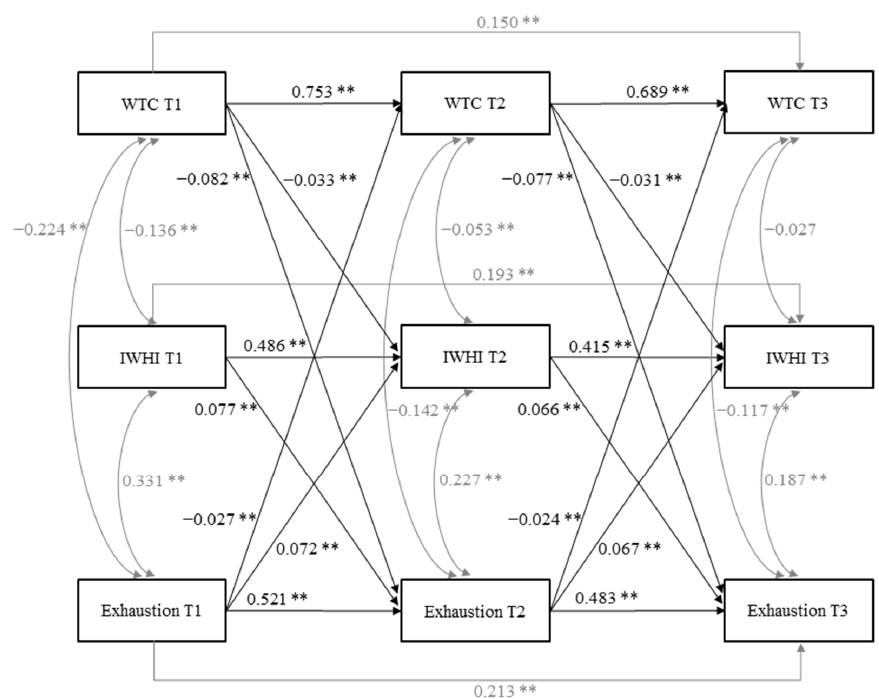
Figure A1. Final model (M5) with standardized coefficients for WTC, IWHI, and exhaustion (unbalanced panel). For clarity, control variables (gender, age, education level, living with a partner, underage child in household, weekly working hours, regular day work, and requirement level) are not shown. Control variables were regressed on the constructs at T1 only. * p < 0.01. ** p < 0.001.